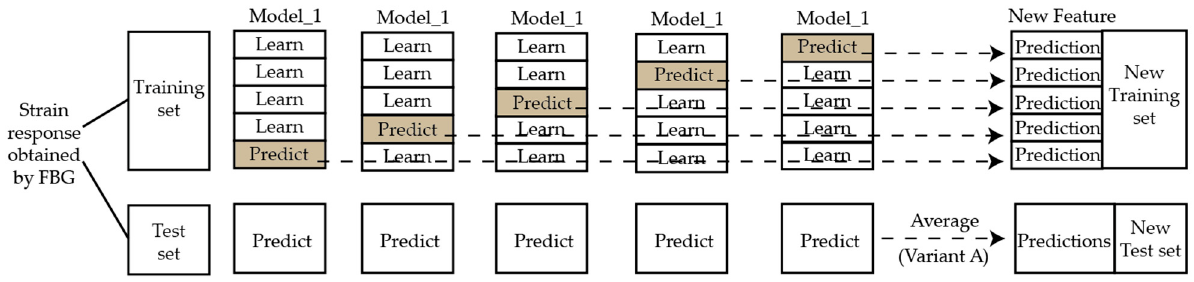
Figure 4. Stacking-based ensemble model for input data processing of